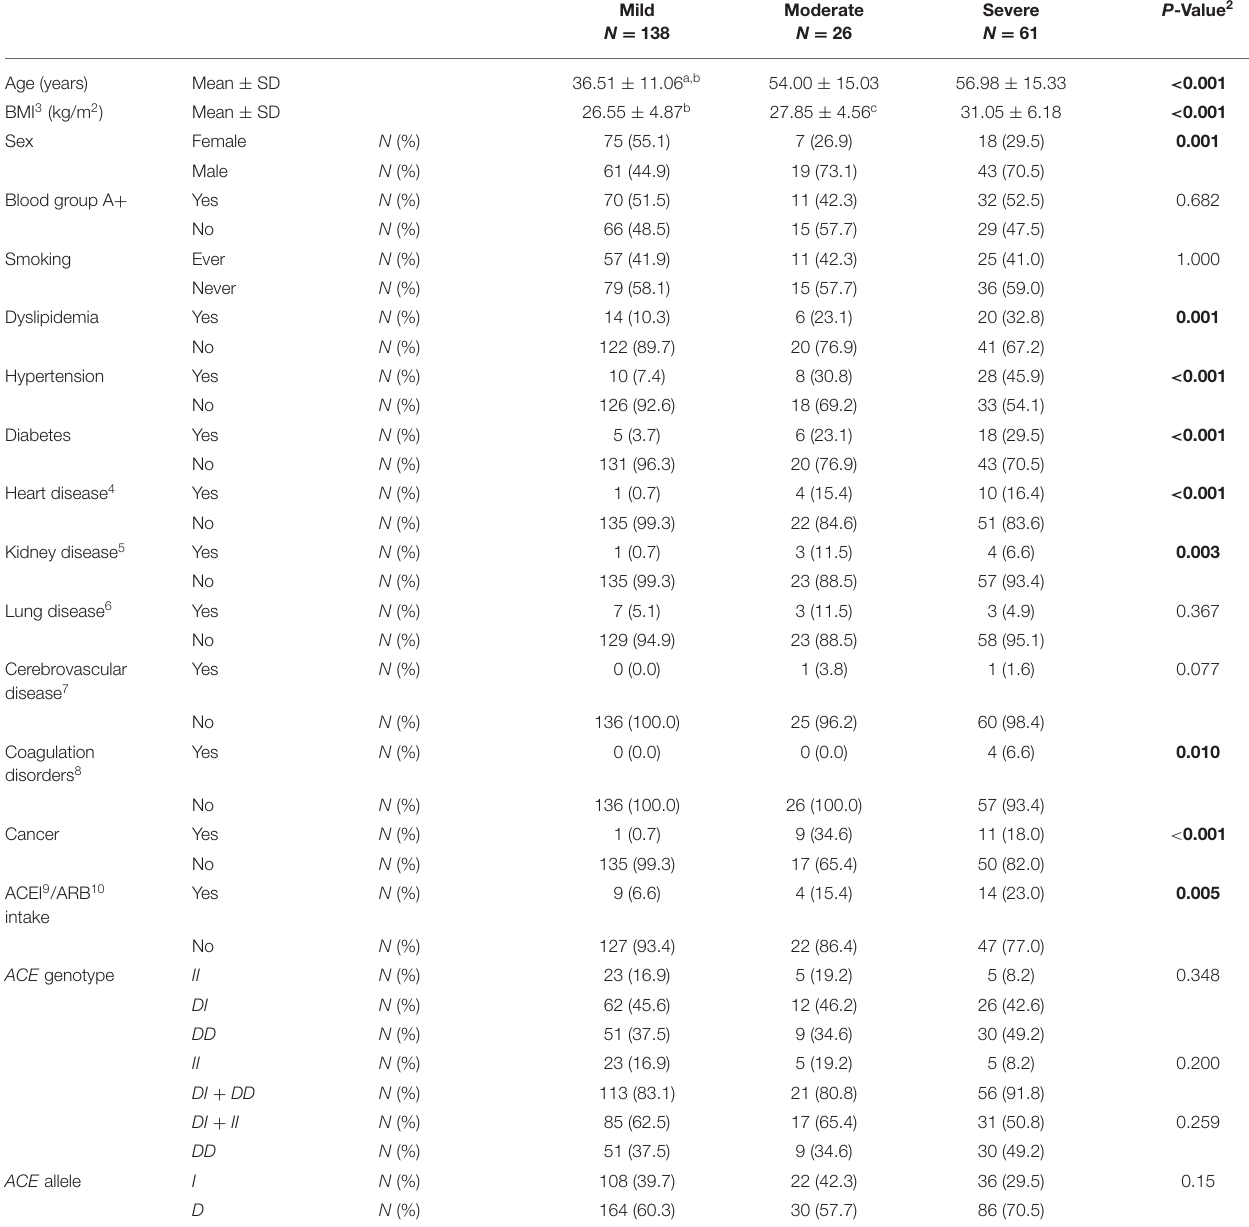
TABLE 2 | Association between baseline characteristics and ACE1 polymorphism with disease severity 1 in symptomatic COVID-19